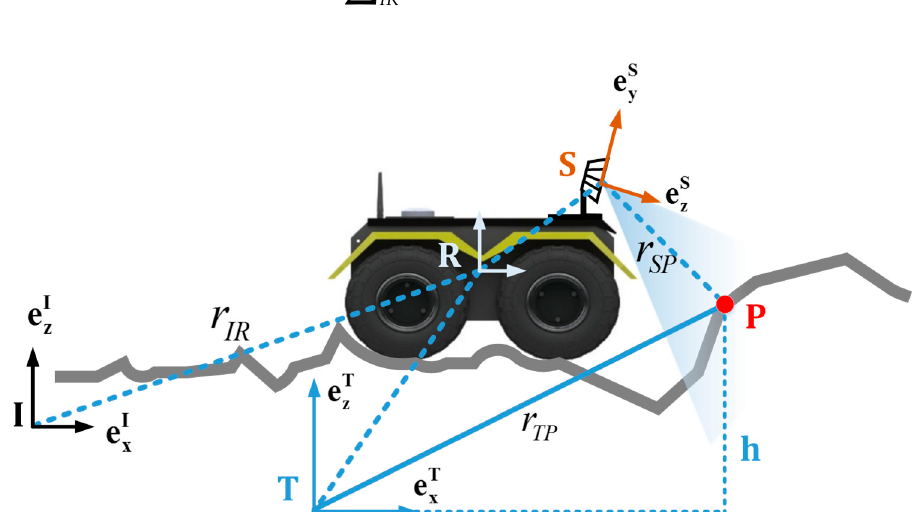
Figure 1. Coordinate system definition and conversion diagram.